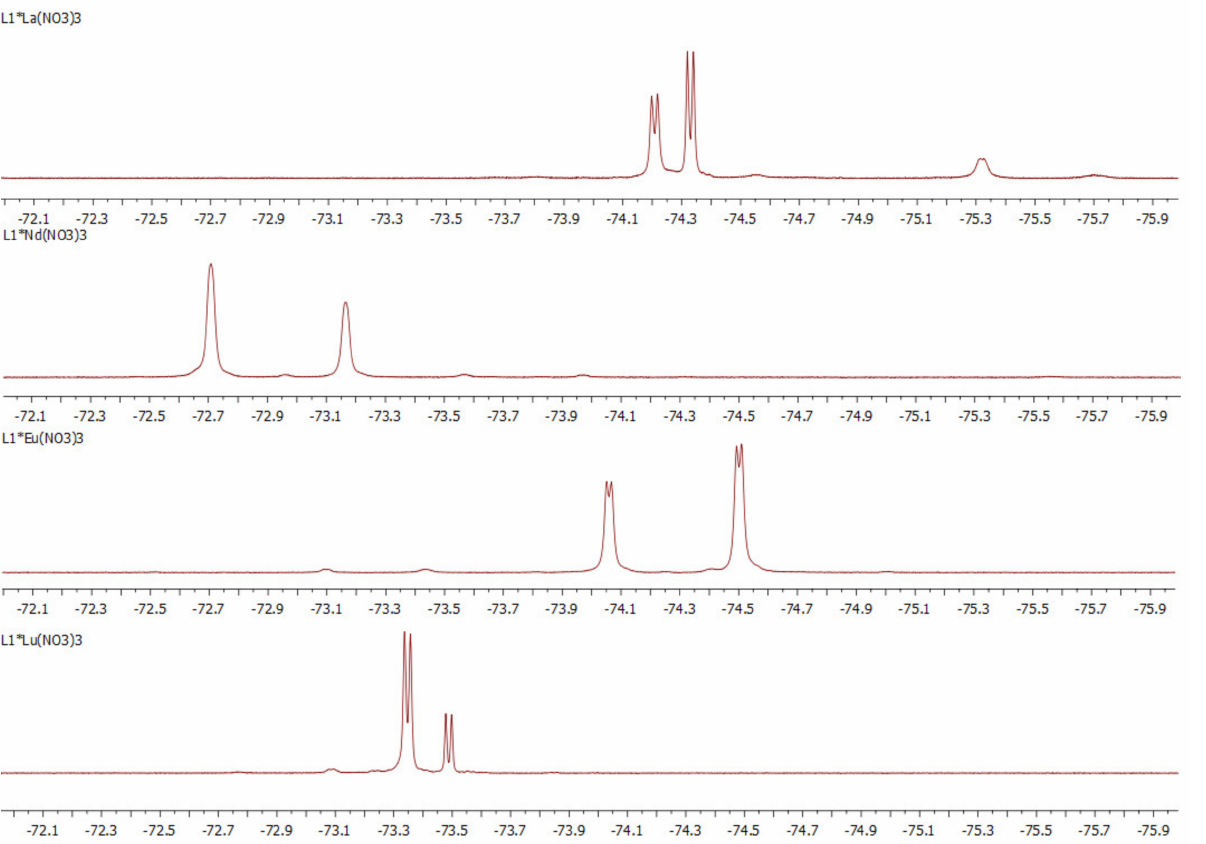
Figure 14. 19 F NMR spectra of 1 · Ln(NO 3 ) 3 complexes in CD 3 CN at 23 ◦